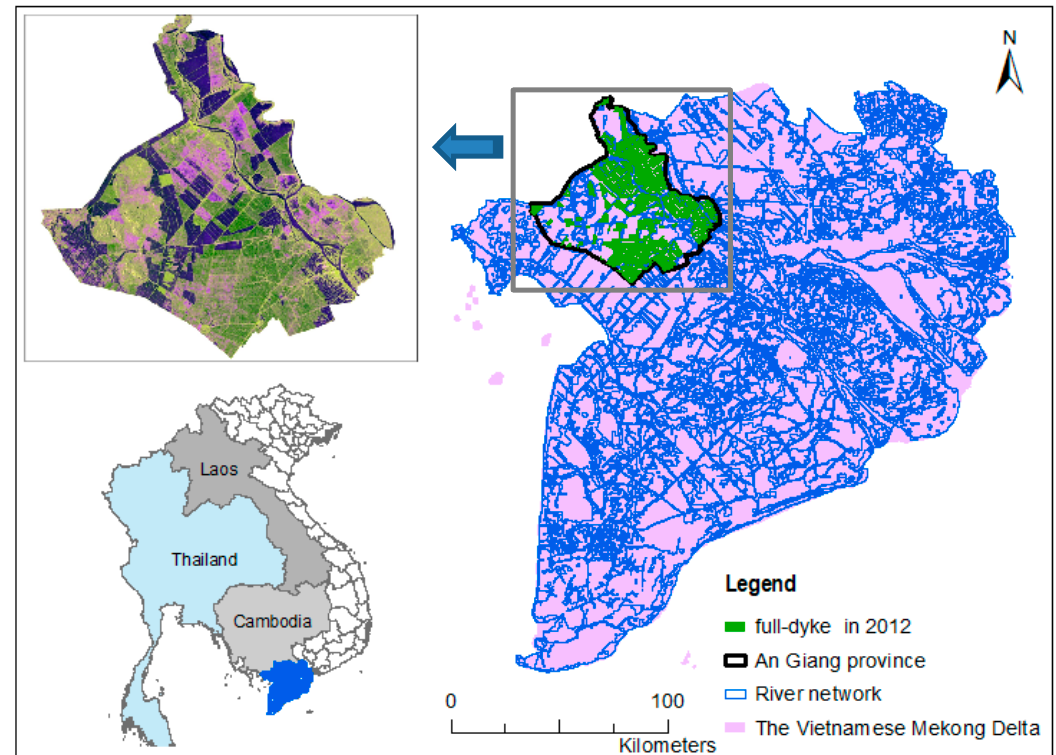
Figure 1. Location of the An Giang province in the Vietnamese Mekong Delta. The display of An Giang province in composite image R:G:B by bands (VV:VH:VV/VH) (date: 2017.10.15).